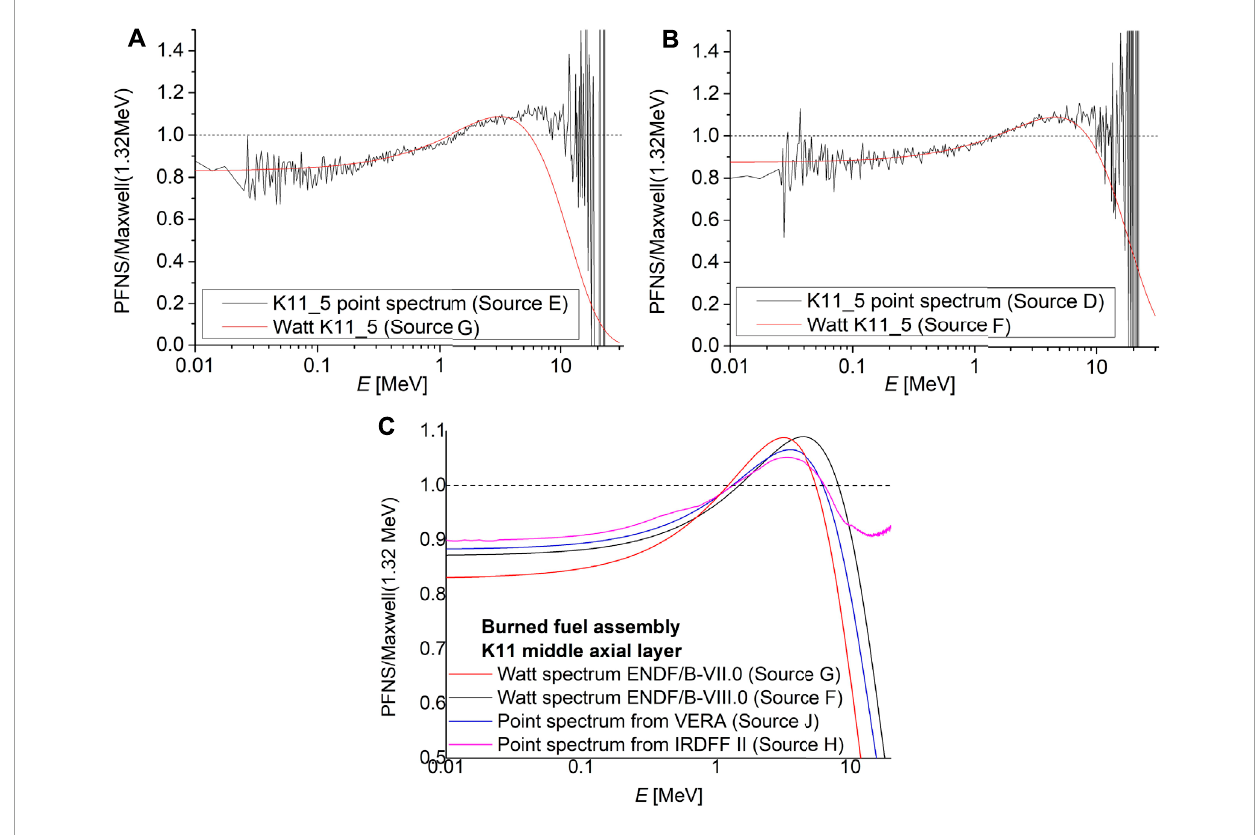
FIGURE 8 Prompt fission neutron spectra relative to the 1.32 MeV Maxwell spectra for burned fuel assembly K11 (middle axial layer) at the core periphery. (A) ENDF/B-VII.0—point-wise values (black) and with fitted Watt spectrum (red). (B) ENDF/B-VIII.0—point-wise values (black) and with fitted Watt spectrum (red). (C) Comparison of different spectrum